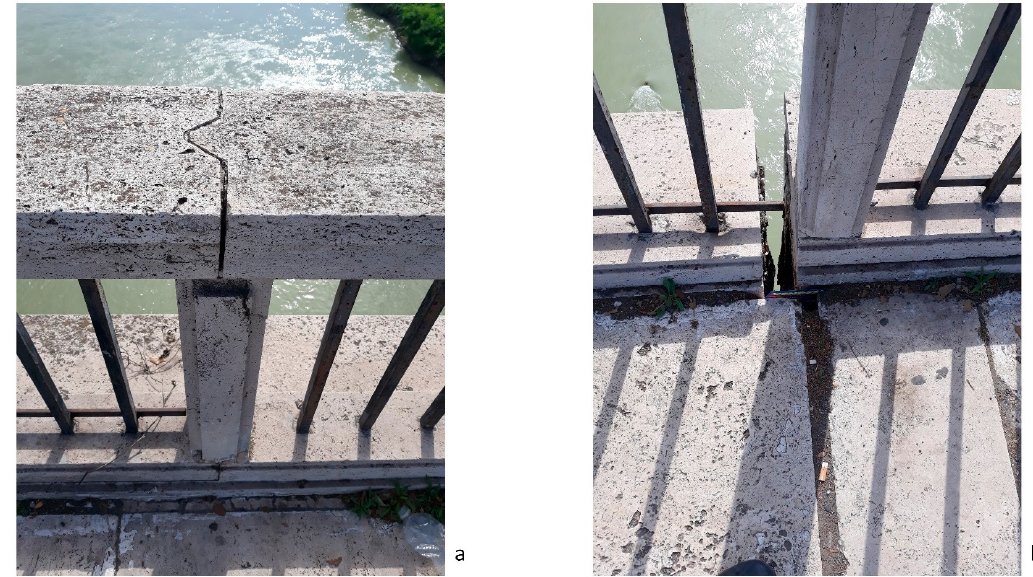
Figure 6. The visible detachments along the sidewalk of Marconi Bridge after Norcia 2016 earthquake ( a , b ).